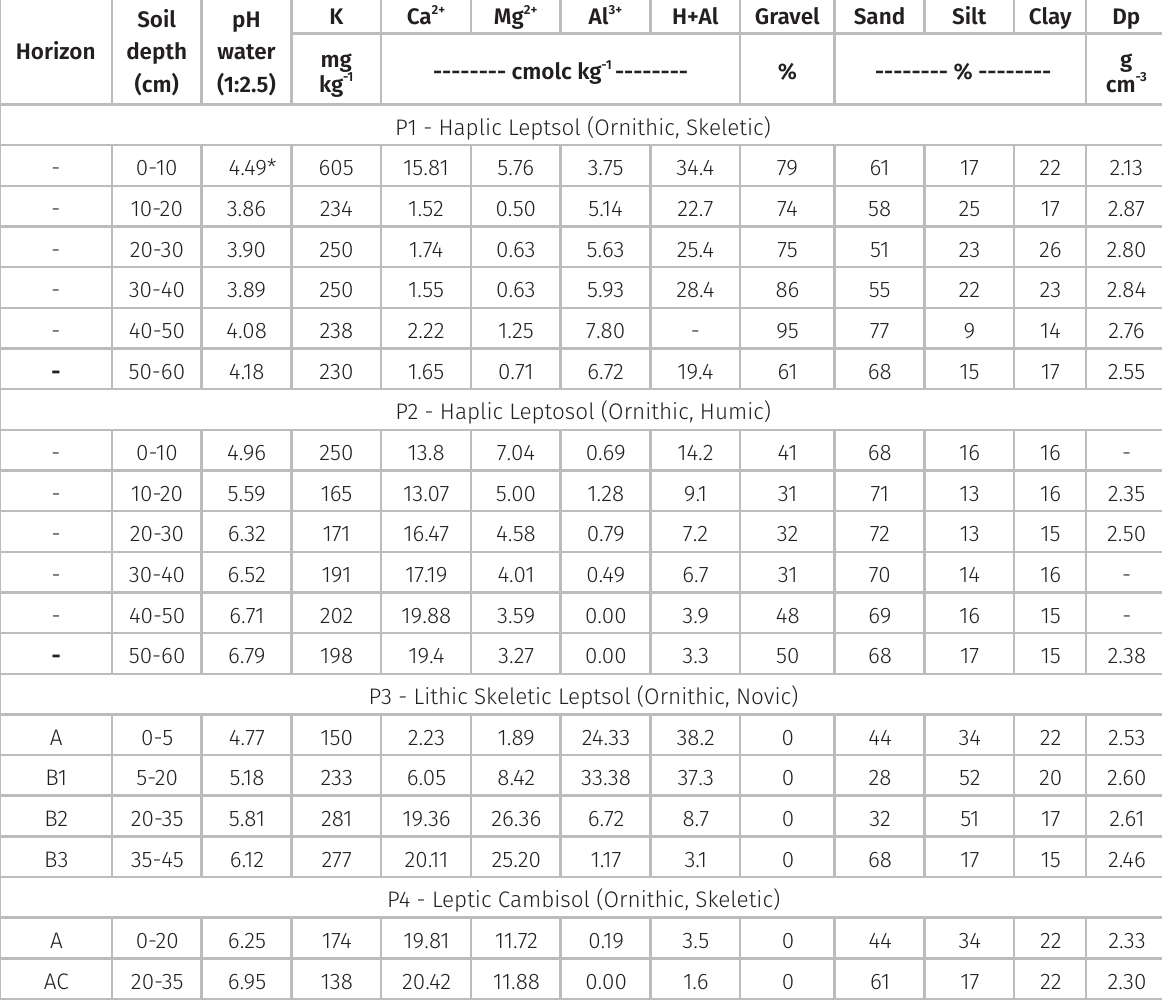
Table I. Soil physical and chemical characterization of samples influenced by gentoo penguins (P1 and P2) in the Livingston Island, and by kelp gulls (P3) and giant petrels (P4) in the Nelson Island,